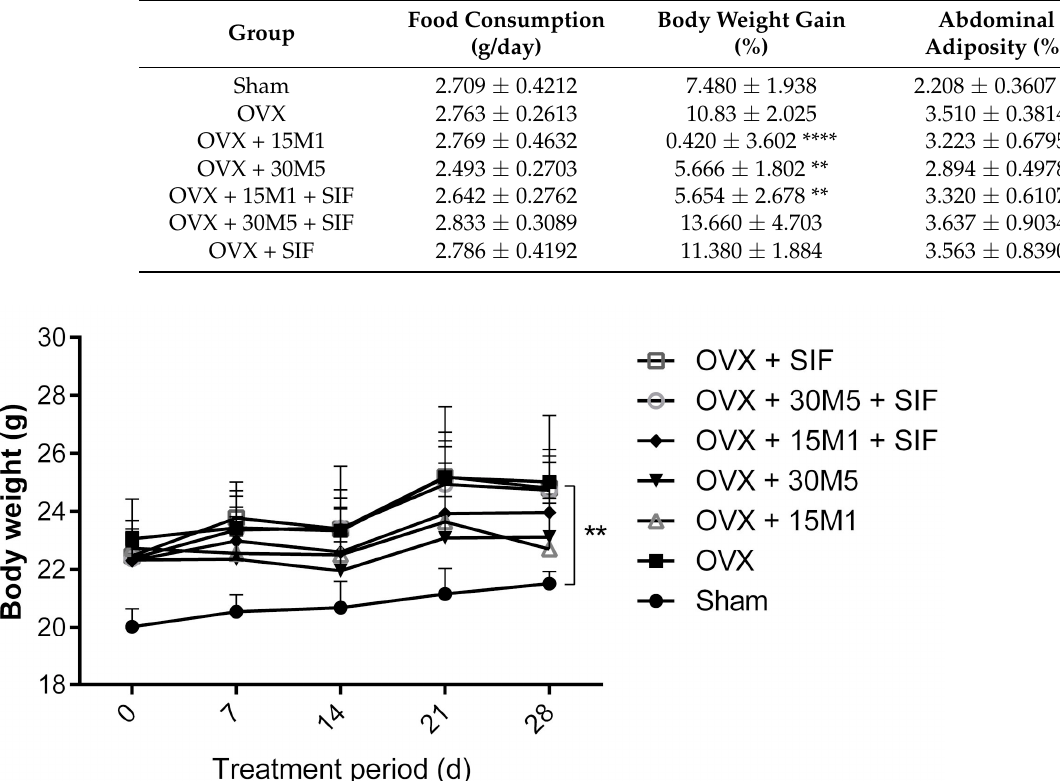
Figure 2. Evolution of body weight during treatment. Data present as the means ± standard deviations (SD). Figure 3 lists the parameters related to metabolic function as measured in the serum.